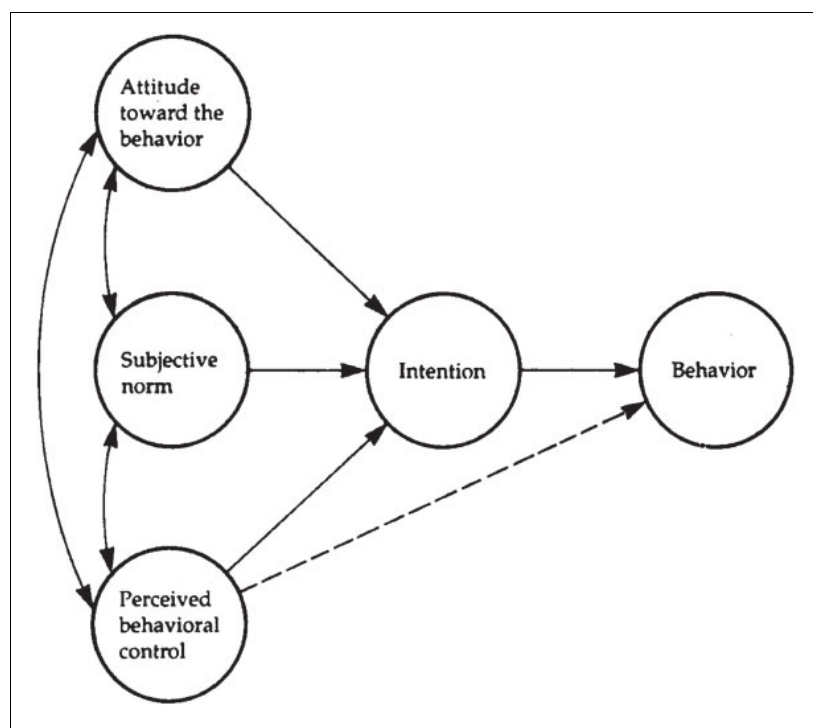
Figure 2. Theory of Planned